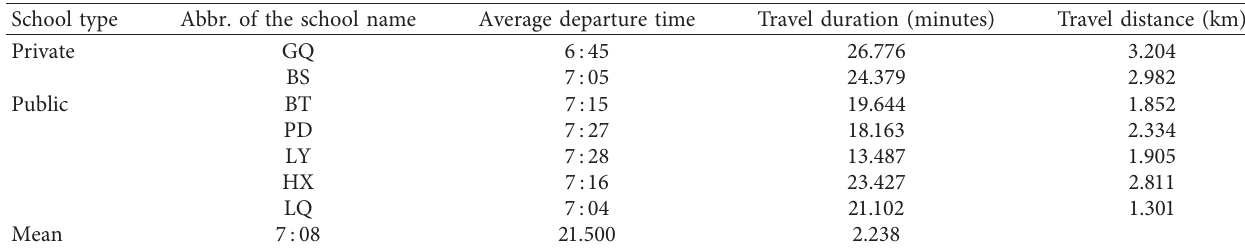
Table 2: Departure time, average travel duration, and distance of school